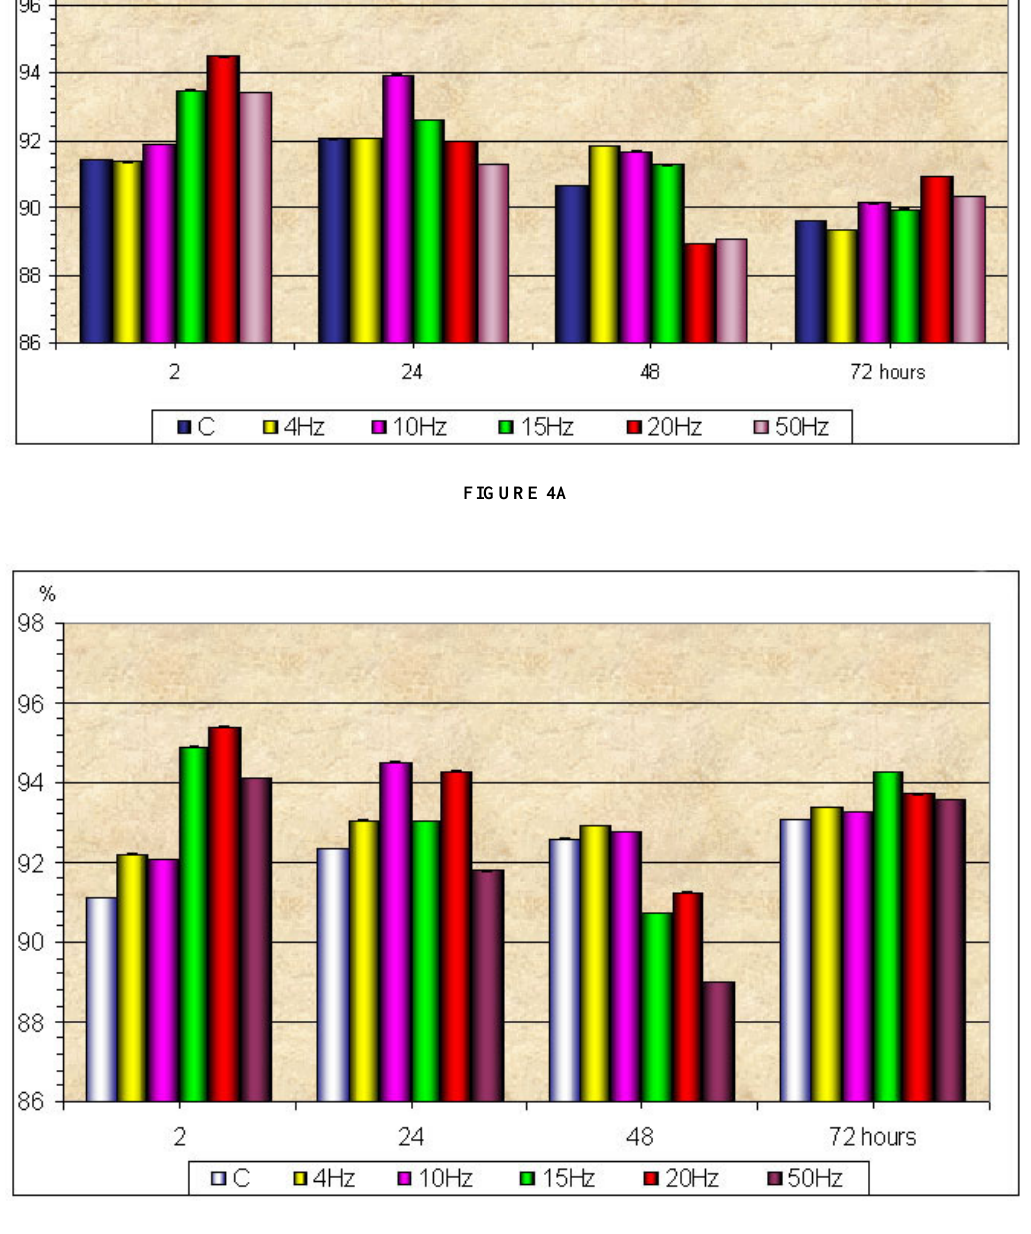
FIGURE 4. The effect of nontreated (control) and LF EMF-pretreated DW on the changes of seed dry weight during 72-h incubation. (A) Seed dry weight at room temperature (20 o C), (B) seed dry weight in cold (4 o C) DW. On abscissa, the time (in hours) of seed incubation; on ordinates, percent of seed dry weight changes comparing to its wet weight 0